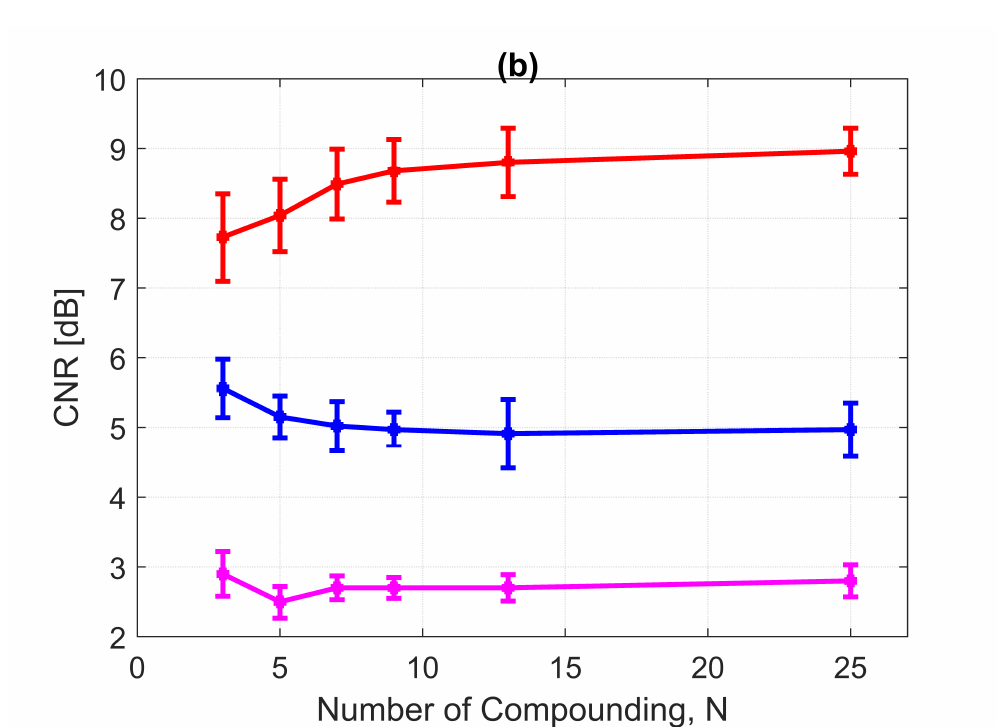
Figure 17. ( a ) CRs and ( b ) CNRs for a 3.0 mm diameter cyst at 15 mm depth employing DAS, FDMAS and